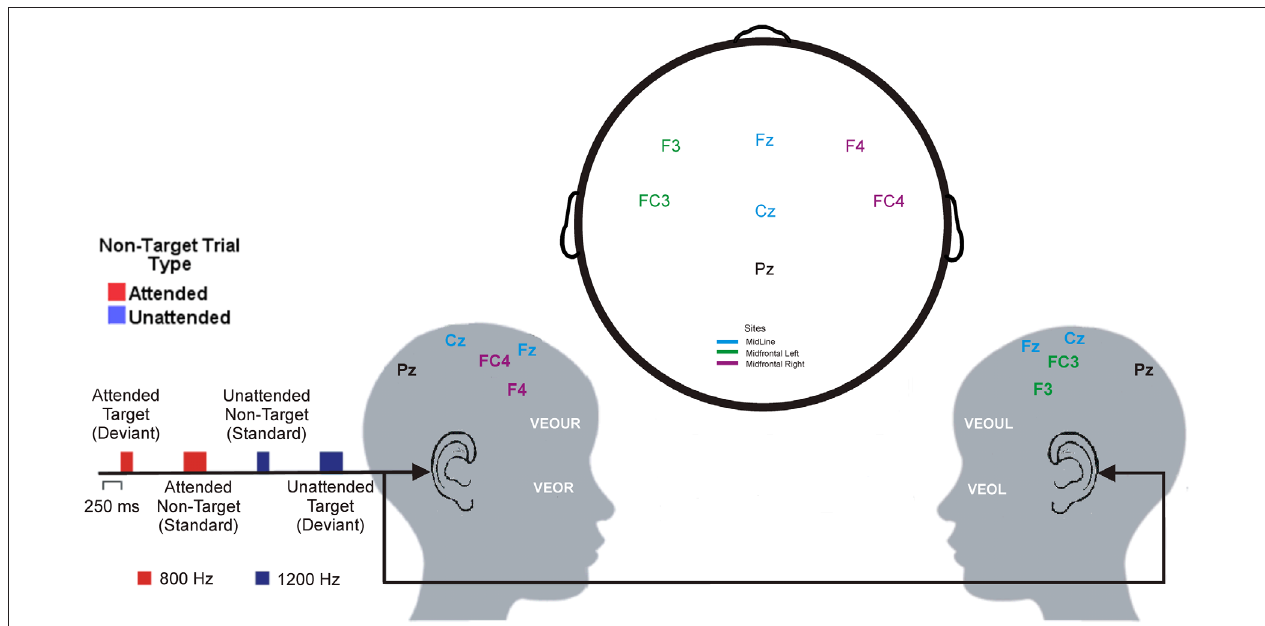
this figure represents a child asked to press a button to the 800-Hz, 250ms tone ( target tone). Thus, the attended tone was 800-Hz, 100ms tone (red) and the unattended tone was the 1200-Hz, 100ms tone